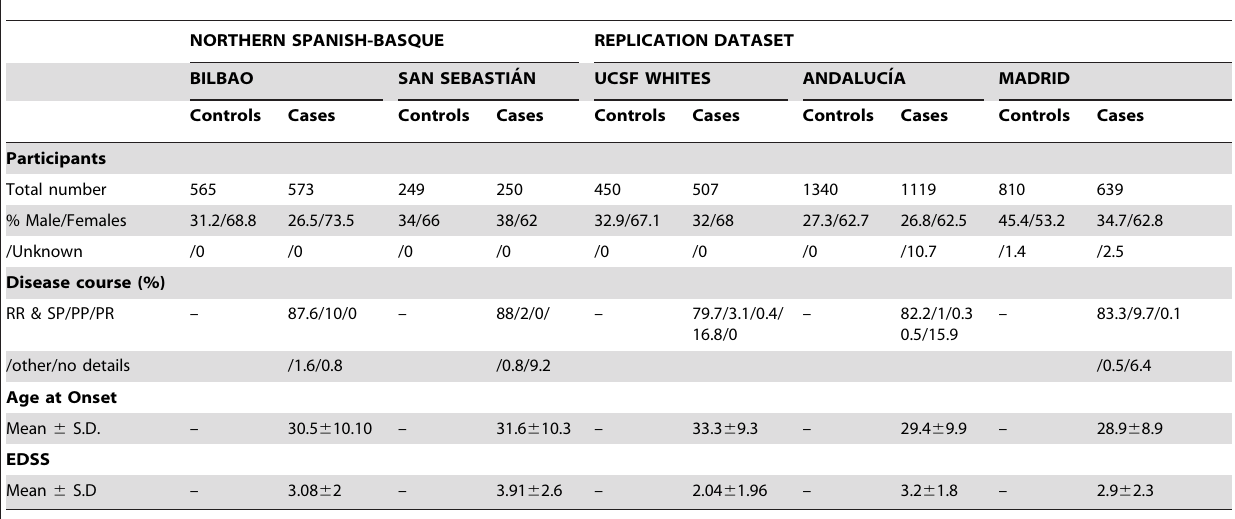
Table 1. Clinical characteristics of the MS patients included in the genetic